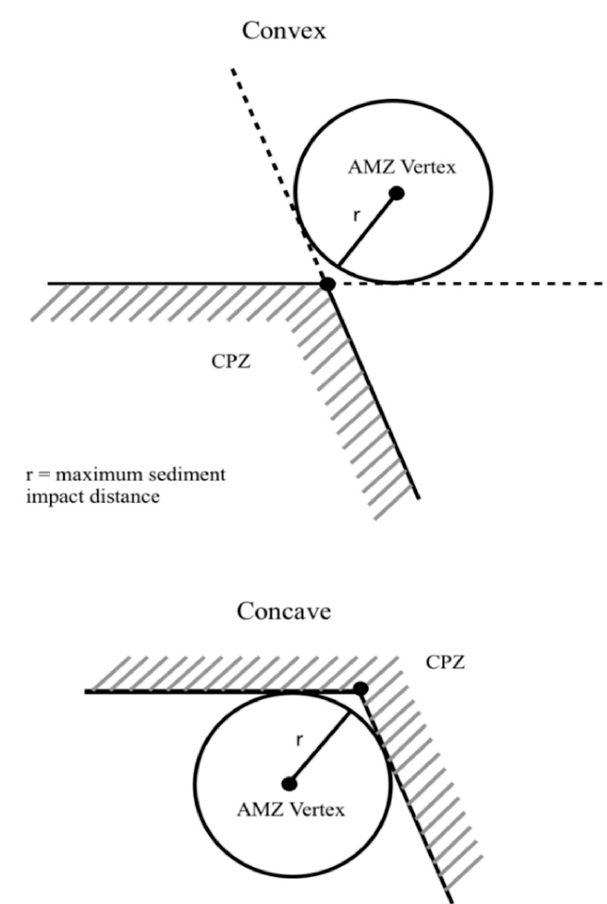
Figure 8. Schematic diagram on how to determine the AMZ vertex for the convex and concave CPZ vertices, respectively. At a convex vertex, the interior angle is smaller than 180°, while at a concave vertex, the interior angle is greater than 180°.